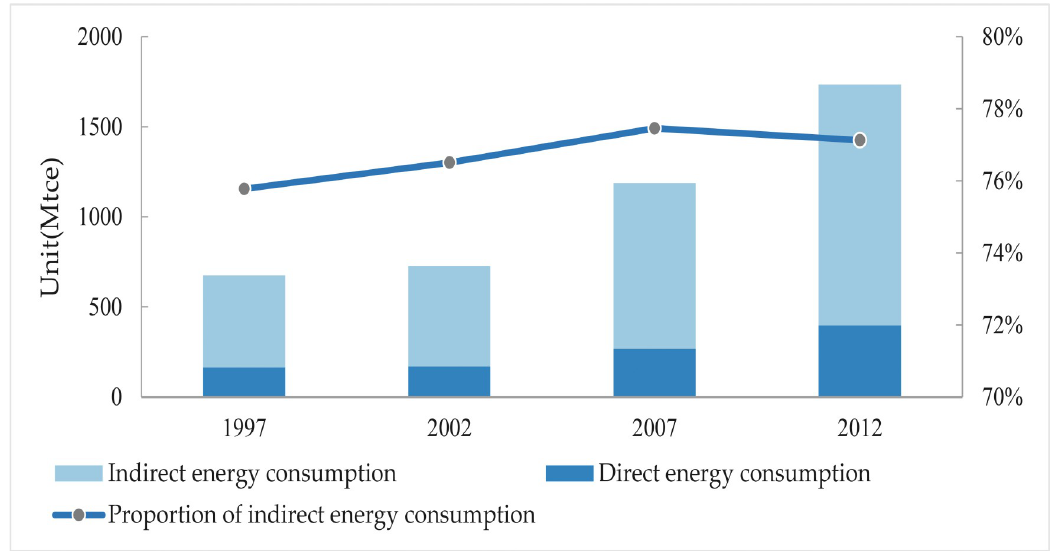
Fig 2. Direct and indirect energy consumption at the household level between 1997 and